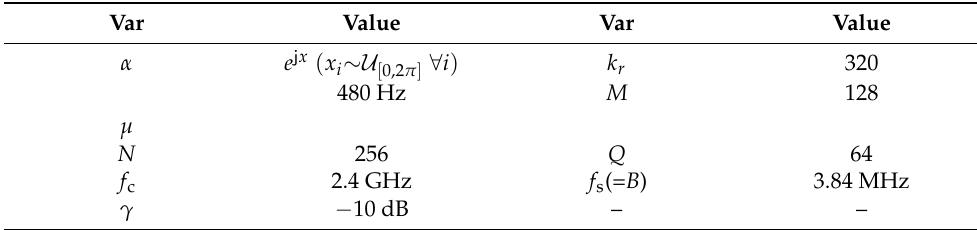
Table 2. Simulation settings for Figure 6, where f c is the carrier frequency, f s denotes the sampling frequency and γ is the SNR of the time-domain echo signal y ( i ) . Var Value Var Value